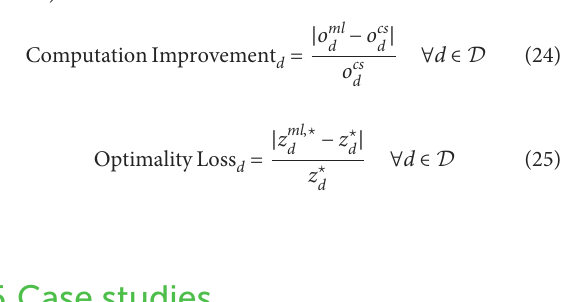
Otherwise, I pre are utilized as warm-start solution for d , i solving Eqs 1 – 13